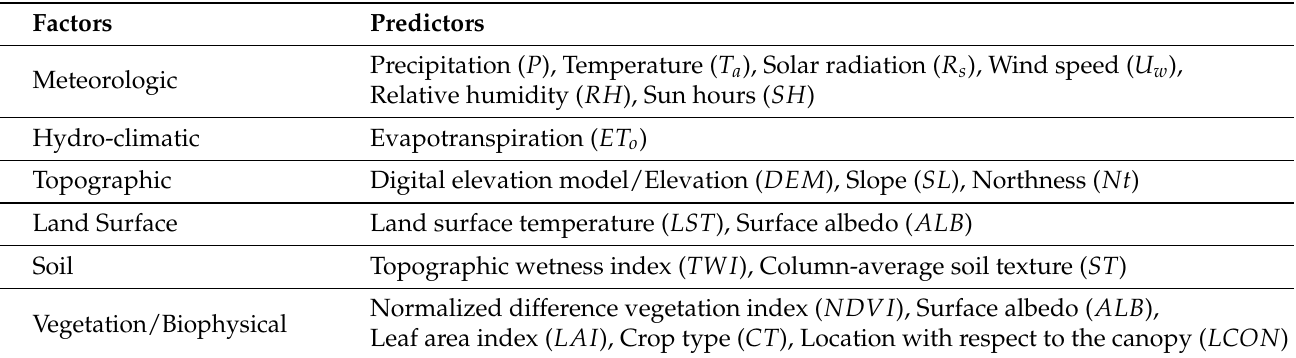
Table 1. Factors and predictors used in IAI-based soil moisture